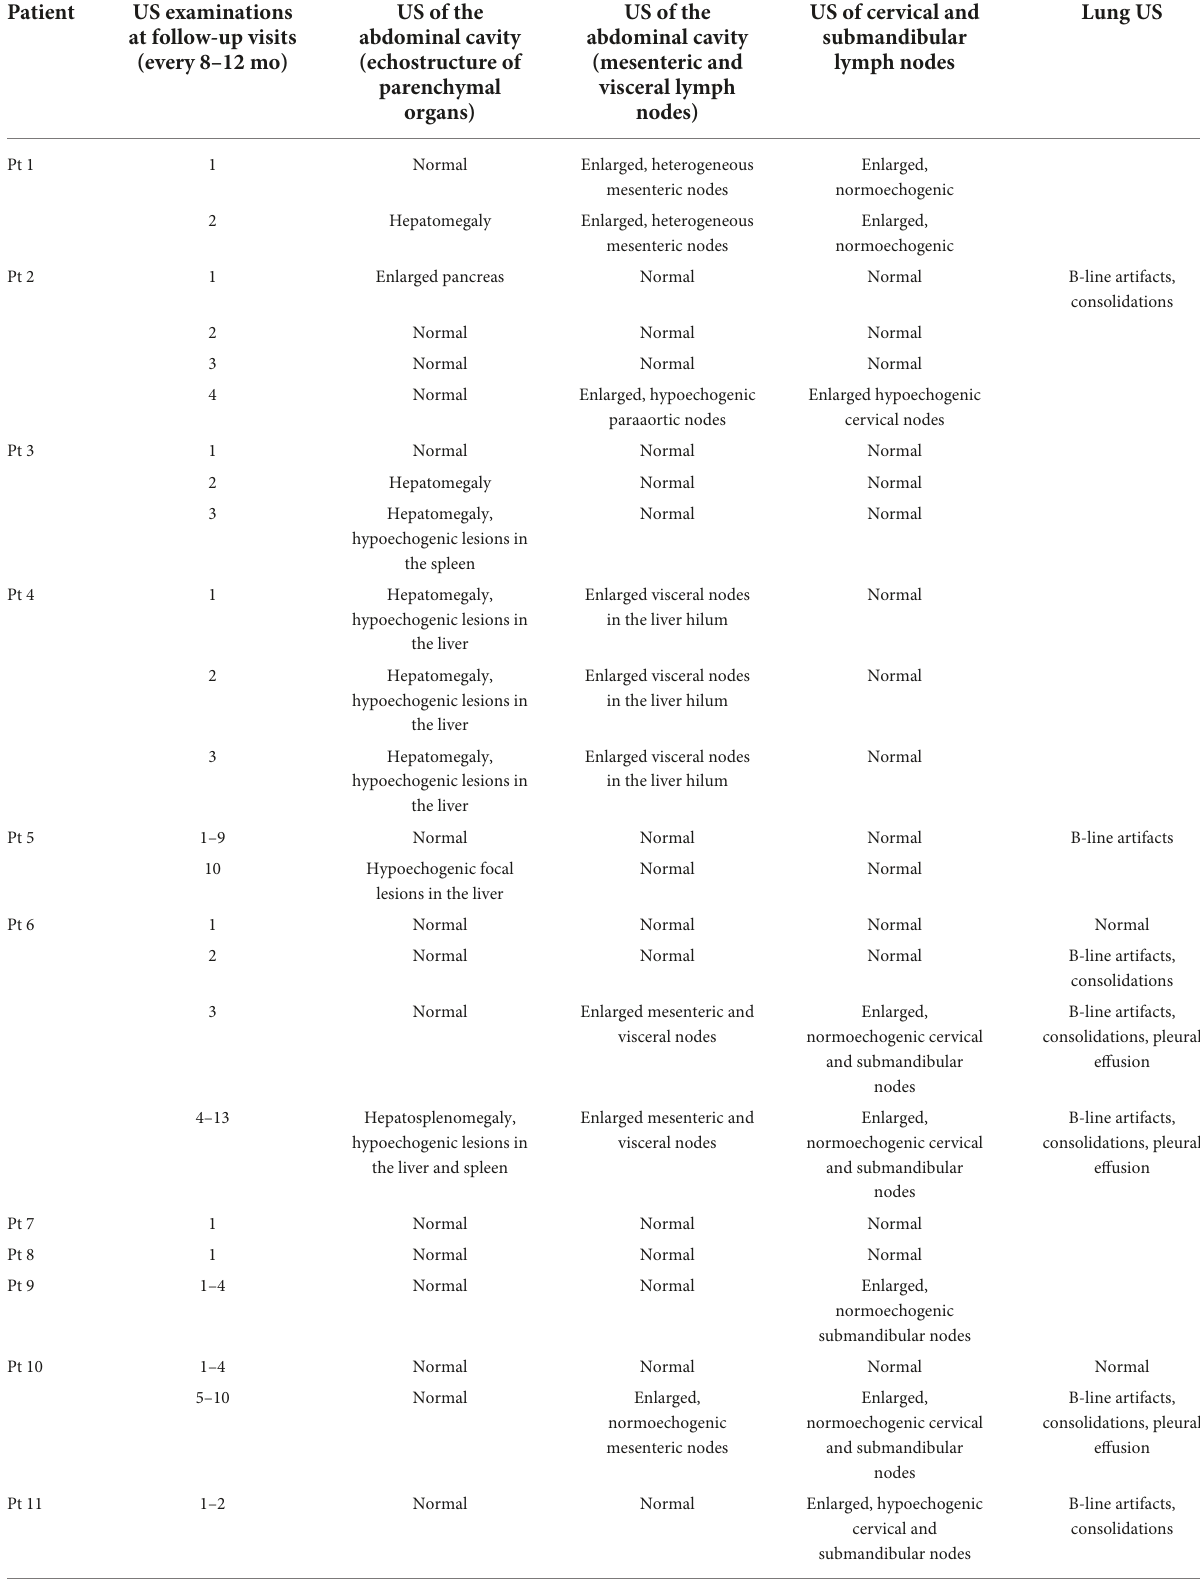
TABLE 3 Findings detected in the abdominal cavity, peripheral lymph node, and lung ultrasound (US) in ataxia-telangiectasia (A-T) children. Results of US examinations in A-T